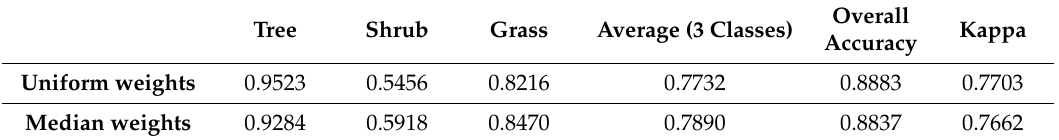
Table 19. Accuracy (uniform and median weights) and Kappa values (Oregon—3 classes).